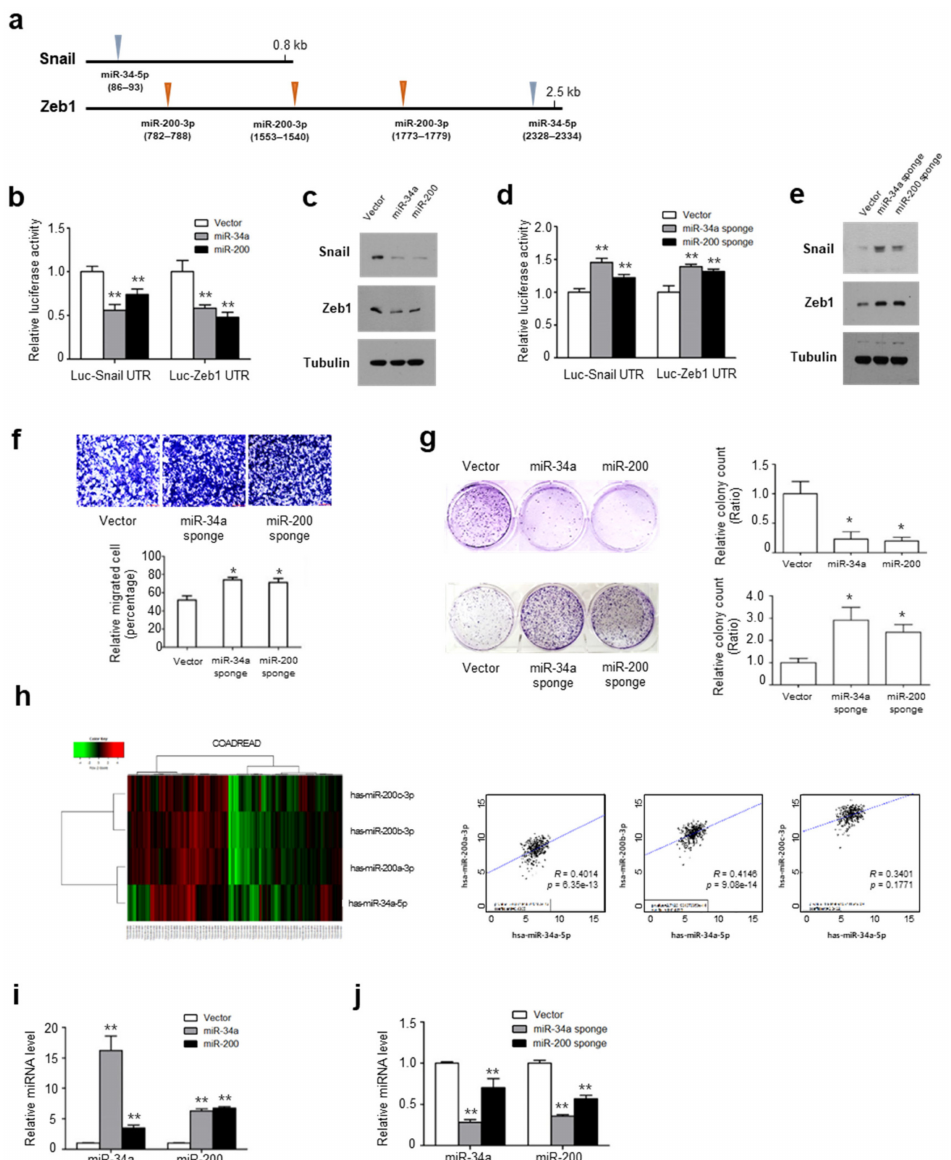
Figure 2. Snail and Zeb1 shared regulatory miR-34a and miR-200: ( a ) Potential matching target sites of miR-34a and miR-200 in the UTR regions of Snail and Zeb1; ( b ) Snail and Zeb1 UTR reporter activity in the HCT116 cells that were transient transfected pMSCV-miR-34a or miR-200 expression vectors. Reporter activity was normalized to the activity of SV40 Renilla (** p < 0.01 compared with control, t -test); ( c ) Immunoblot analysis of endogenous Snail and Zeb1 level after transfection of miR-34a or miR-200 vectors. Representative blots are shown from at least two independent experiments; ( d ) Snail and Zeb1 UTR reporter activity in HCT116 cells transfected with miR-34a or miR-200 sponge vector (** p < 0.01 compared with control, t -test); ( e ) Immunoblot analysis of endogenous Snail and Zeb1 level after inhibition of miR-34a or miR-200 by the transfection of sponge vector. Representative blots are shown from at least two independent experiments; ( f ) Representative migration images in HCT116 cells transfected with miR sponge vector (upper panel). Migratory activities after function loss of miR-34a and miR-200. Results are representative of five independent experiments (lower) (* p < 0.05 compared with vector, Mann–Whitney test); ( g ) Clonogenic survival assay against paclitaxel in HCT116 cells with transfection of miRs overexpression vector or miRs sponge vector (* p < 0.05 compared with control, Mann–Whitney test); ( h ) Unsupervised hierarchical clustering based on miR-34a and miR-200 expression profiles (right panel) and Pearson correlation scatter plots (left panel) of miR-34a and miR-200 transcript in colorectal cancers; ( i , j ) Quantitative PCR analysis of miR-34a or miR-200; ( i ) After transfection with an miR-34a and miR-200 expression vector and ( j ) After transfection with miR-34a or miR-200 sponge vector (** p < 0.01 compared with control, t